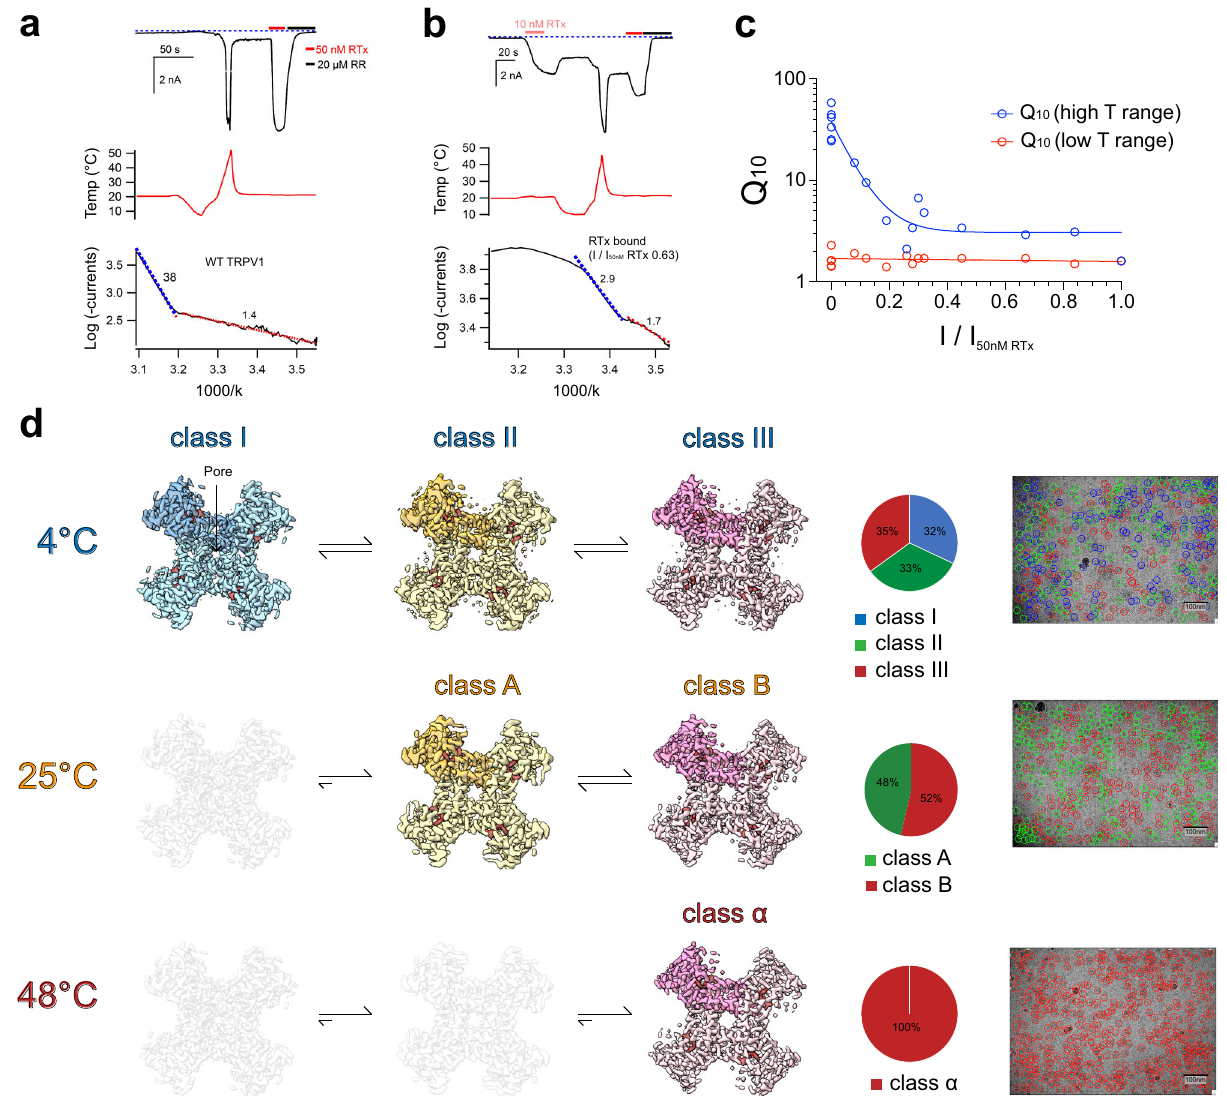
Fig. 1 Thermal titration cryo-EM experiment and the effect of RTx on TRPV1 heat sensitivity. a A representative macroscopic current time-course (top panel) recorded from a HEK-293T cell expressing rat TRPV1 in response to the temperature ramp (10 – 50 °C) at a membrane potential of − 60 mV and then followed by a saturating concentration of RTx (50 nM) and 20 µ M ruthenium red (RR). The dashed line indicates zero current. The recorded temperature is shown in the middle panel. The Arrhenius plot for the temperature activation was shown in the bottom panel. Fitted Q 10 values for high (blue line) and low (red line) temperature ranges are shown. b A representative time-course recording for RTx-bound TRPV1 temperature sensitivity. First the channel was challenged by 10 nM RTx for ~20 s followed by a temperature ramp (10 – 48 °C), then a saturating concentration of RTx (50 nM) was introduced, and fi nally RR (20 µ M) was applied to completely block the channel. The dashed line indicates zero current. The recorded temperature is shown in the middle panel and the Arrhenius plot for the temperature activation is shown in the bottom panel. Fitted Q 10 values for high and low temperature (T) ranges are shown. c Q 10 values as a function of I/I 50nM RTx for low and high temperature ranges. Each experiment was conducted as shown in a and b . The low T range Q 10 value is steady at 1.7, while the high T range Q 10 rapidly collapses from ~38 to ~3. Each pair of high and low temperature sensitivity data points represents independent time-course recordings from individual cells ( n = 17 cells). Source data are provided as a Source Data fi le. d Representative micrographs of TRPV1 recorded in the presence of 50 μ M RTx at 4 °C, 25 °C and 48 °C, respectively. Cryo-EM maps of RTx-TRPV1 determined at 4 °C (class I, class II, and class III), 25 °C (class A and class B), and 48 °C (class α ). Note the differences between central pore sizes amongst different classes at 4 °C. The classes not found in each dataset are shown as transparent. The pie charts depict particle distributions among classes for each dataset along with representative micrographs. Each pie chart represents an average value for four independent data processes (Supplementary Fig. 2a,